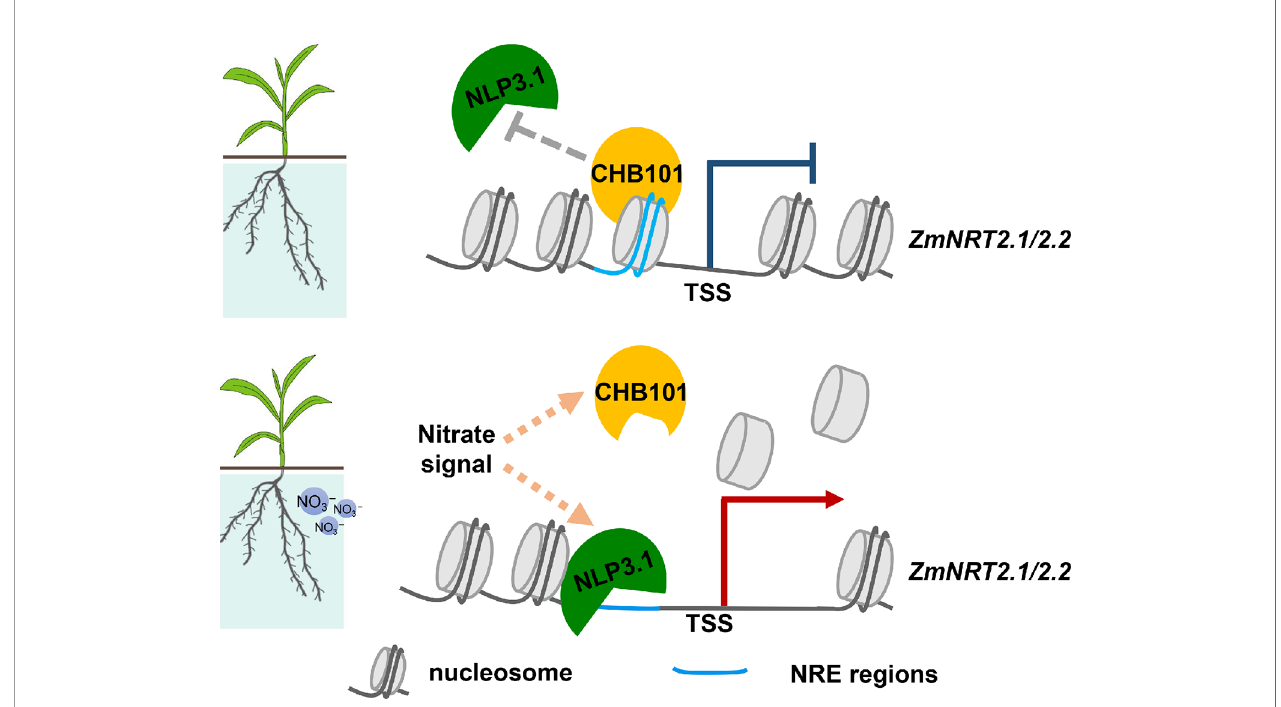
FIGURE 7 | The role of ZmCHB101 in nitrate response in maize. Under nitrate deprivation condition, the ZmCHB101 protein bound to the nitrate-responsive cis - elements (NREs) and maintained the nucleosome occupancies at these sites, thereby may impact the binding of ZmNLP3.1 to NREs, and suppresses the expression of ZmNRT2.1 and ZmNRT2.2 . In the presence of nitrate, the binding af fi nity of ZmCHB101 for NREs decreased dramatically, thus decreasing the nucleosome density at NREs and consequently increasing the binding of ZmNLP3.1 to NREs, thus activate the expression of ZmNRT2.1 and ZmNRT2.2